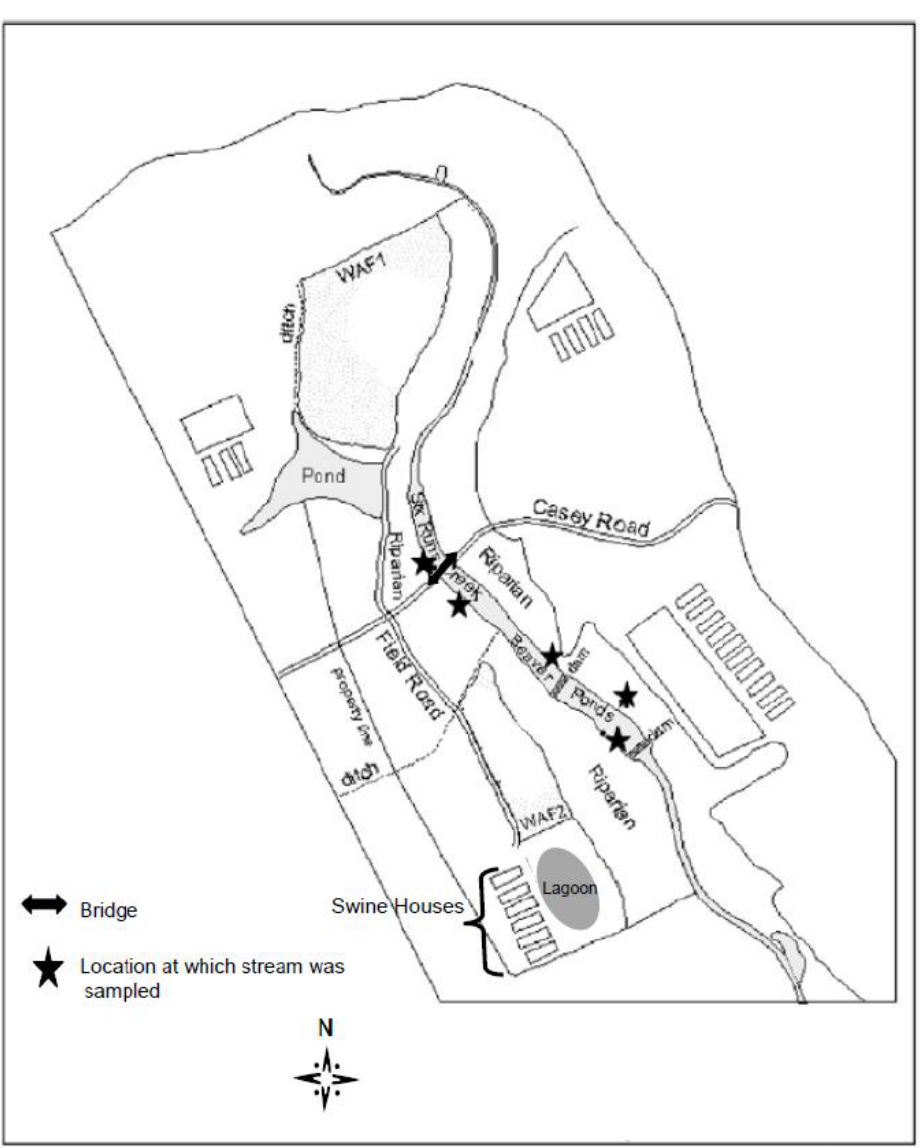
Figure 1. Map of the study site. WAF1 = Waste application field site one; WAF2 = Waste application field site